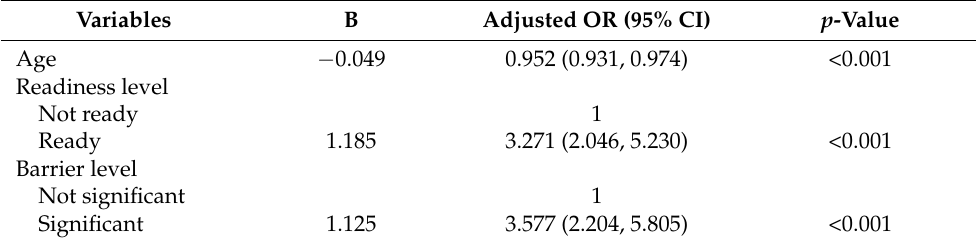
Table 3. Multiple Logistic Regression based factors on knowledge scores of night market street food hawkers about supporting the single-use plastic reduction program ( n = 440).